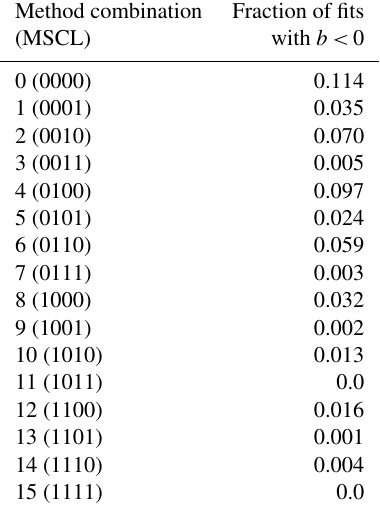
Table 2. Fraction of recessions with non-physical recession expo- nent ( b < 0) for each method